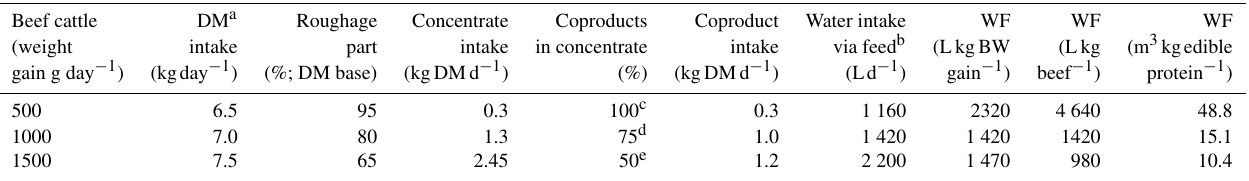
Table 11. Model calculation of water footprint (WF) for beef cattle from 150 to 550kg body weight depending on the daily weight gain and coproducts in feeding.